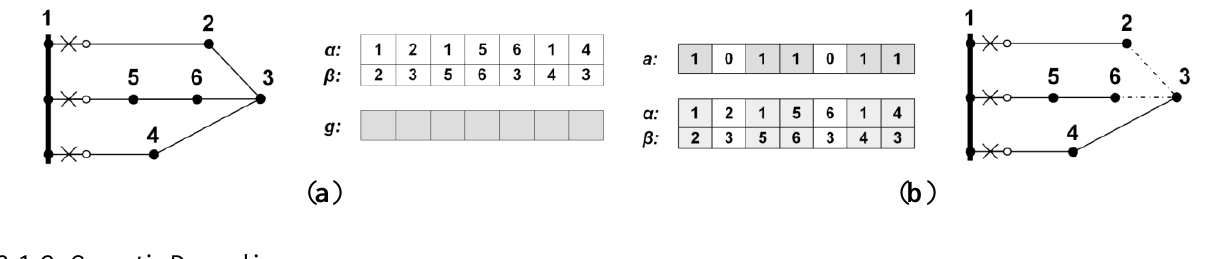
Figure 4. A power distribution system: ( a ) the branch lists of the attached graph (α and β) and the attached chromosome ( g ); ( b ) Branch lists (α and β) obtained by decoding the chromosome a